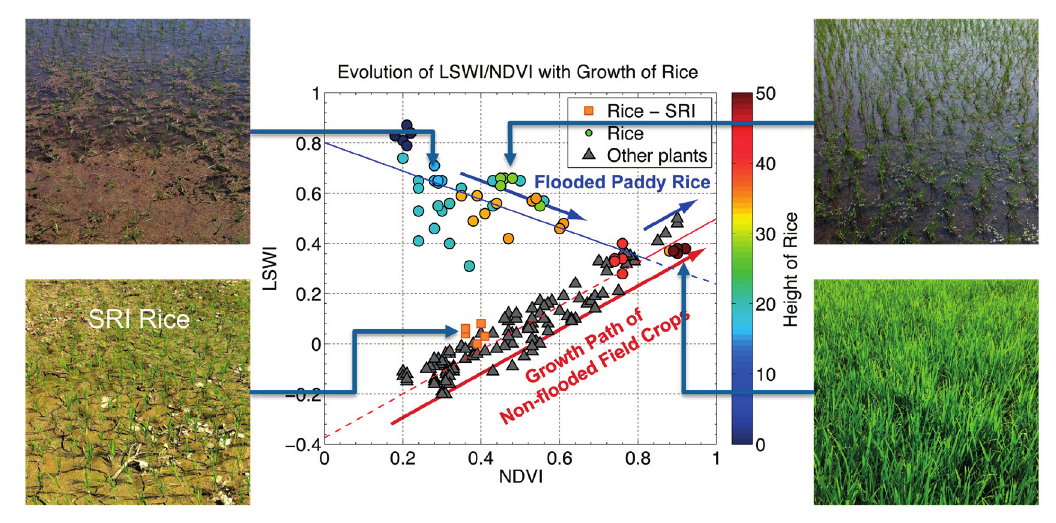
Figure 6. Comparison of indices (NDVI and LSWI) for samples collected in the paddy rice and the other non-flooded crop fields (AILSPEX-11,